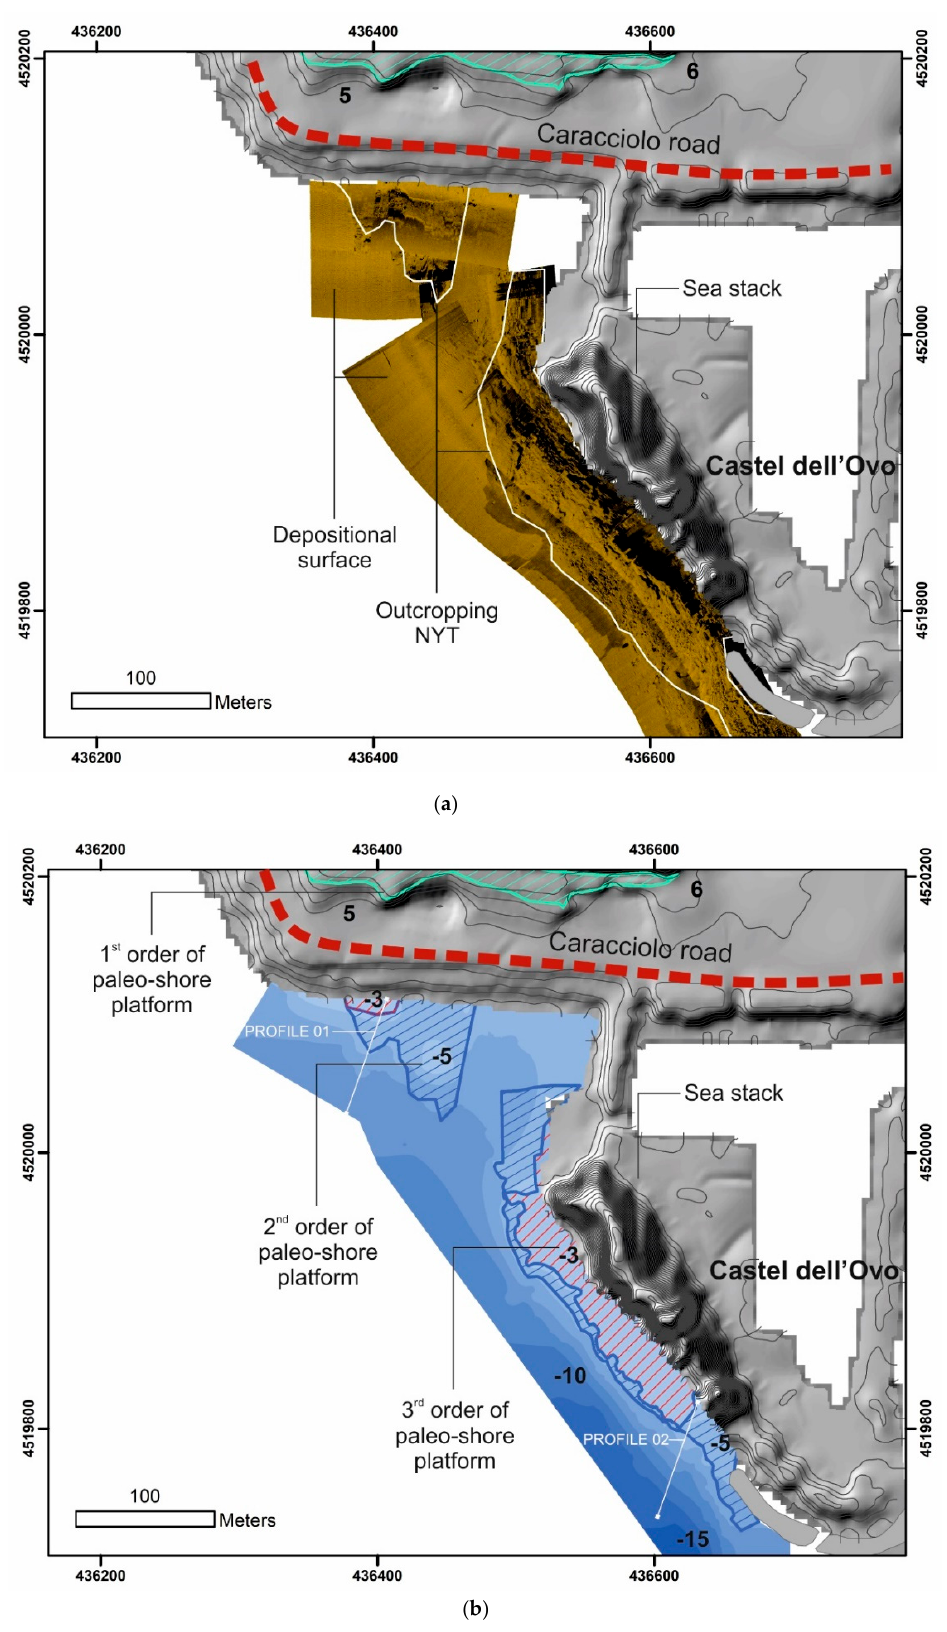
Figure 12. ( a ) Side Scan Sonar (SSS) map of the nearshore sector of Castel dell’ Ovo islet; ( b ) Bathymetric map of the nearshore sector of Castel dell’ Ovo islet with the precise mapping of the second (blue dashed lines) and third (red dashed lines) order submerged paleo-shore platforms (after Pappone et al., [45]).